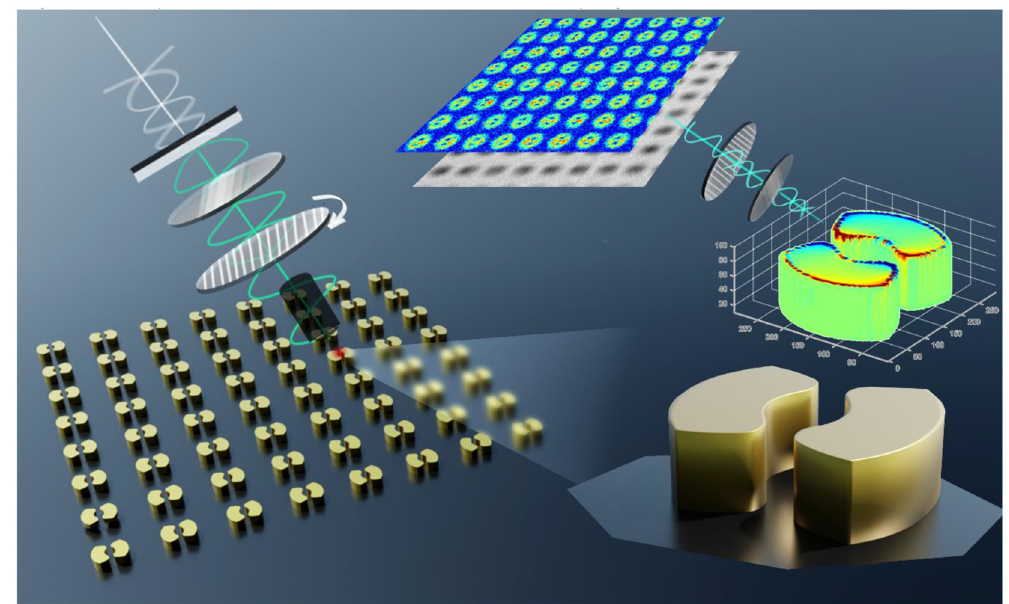
Figure 1: Schematic of plasmonic modes detection under indirect polarized imaging system.